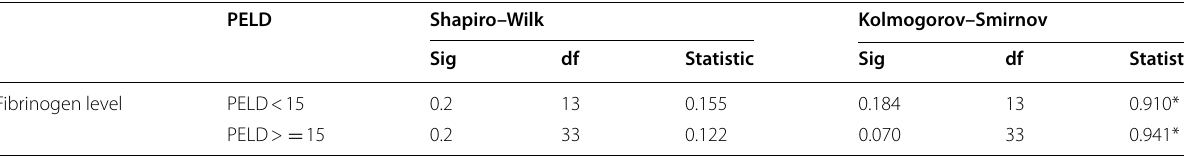
* This is a lower bound of the true